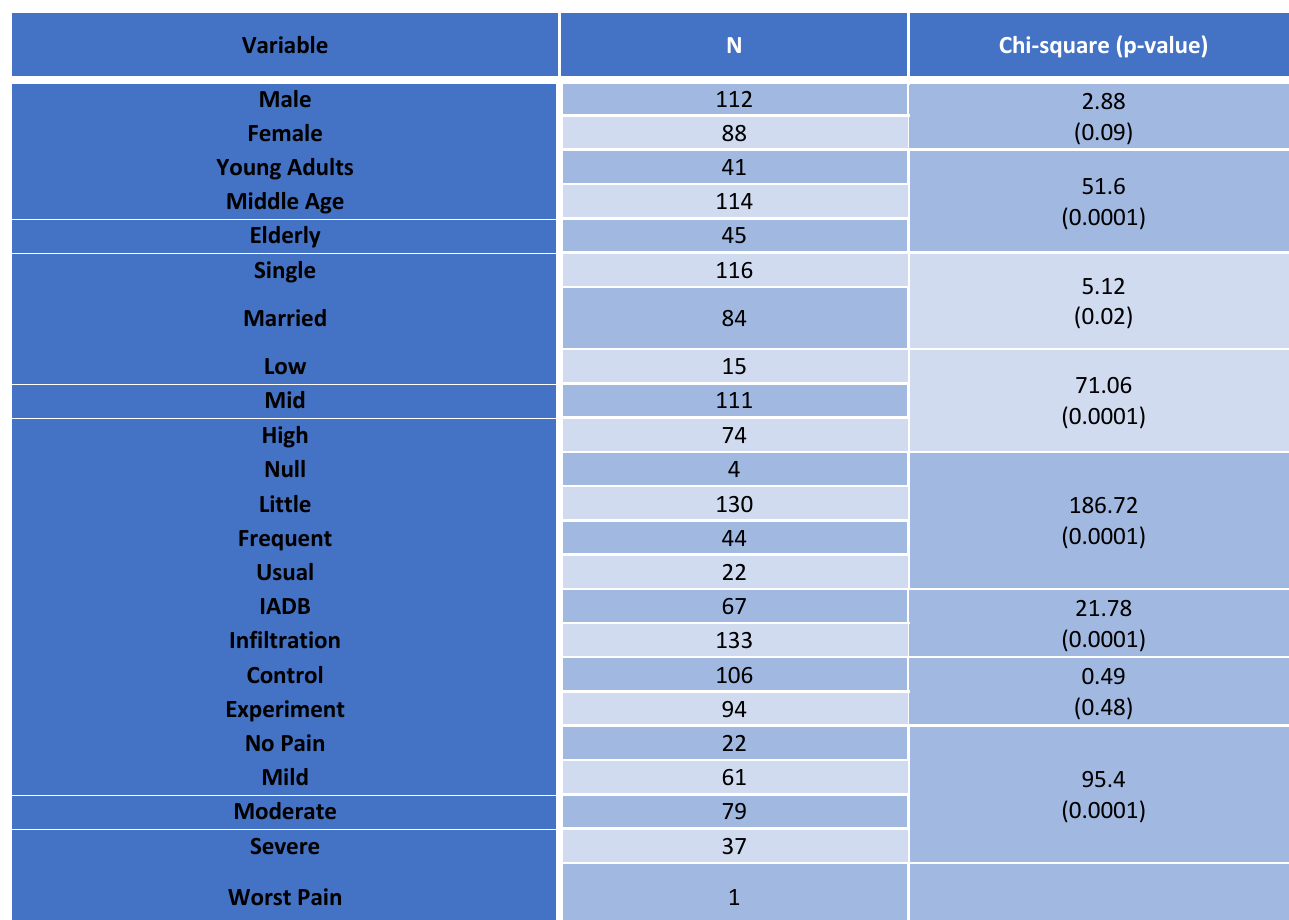
Table 1. Distribution of variables in the sample